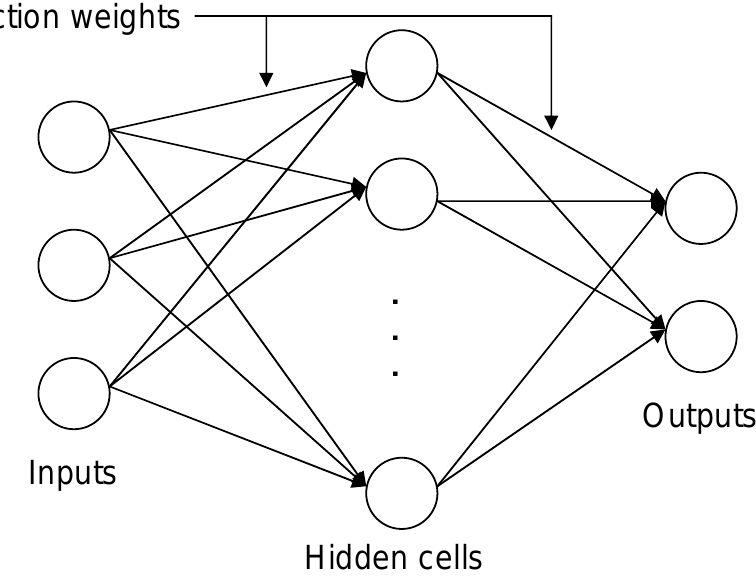
Figure 3. A generic three-layer feed-forward neural